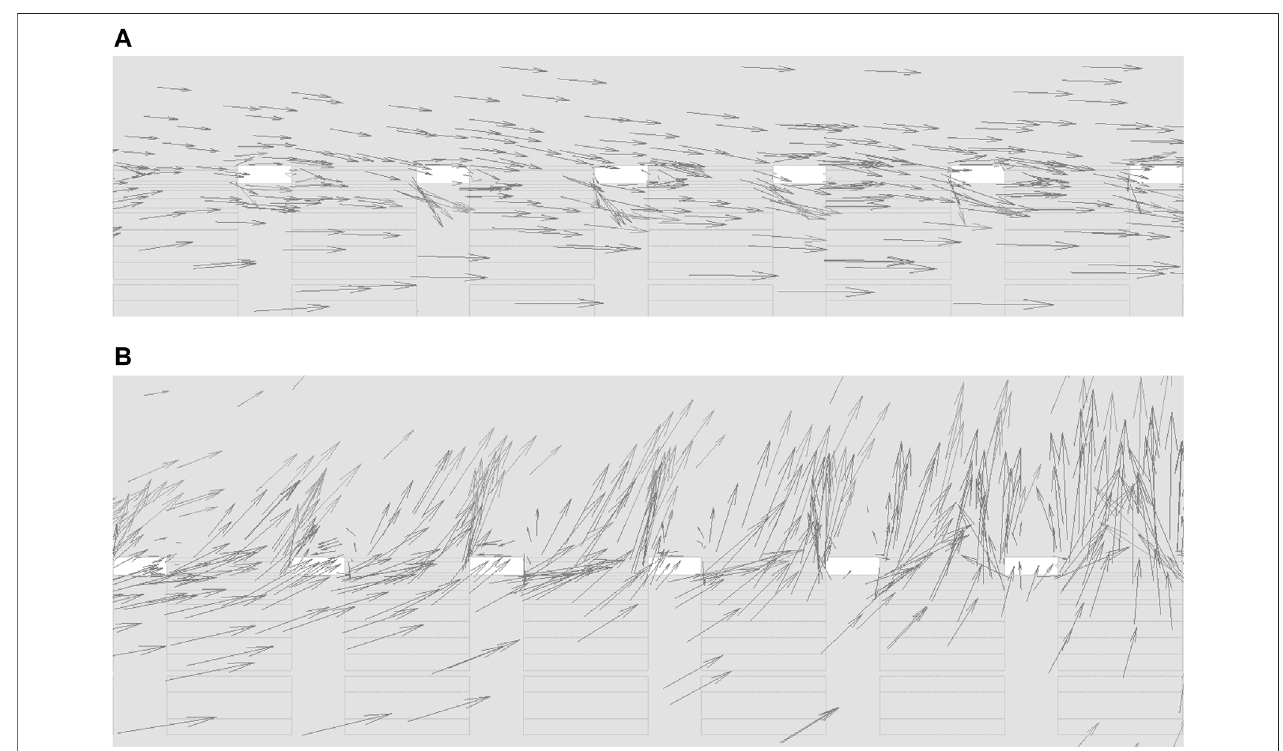
FIGURE 10 | Local velocity vector of the fl ow homogenizer with UASHs. (A) Near the inlet side. (B) Away from the inlet side.